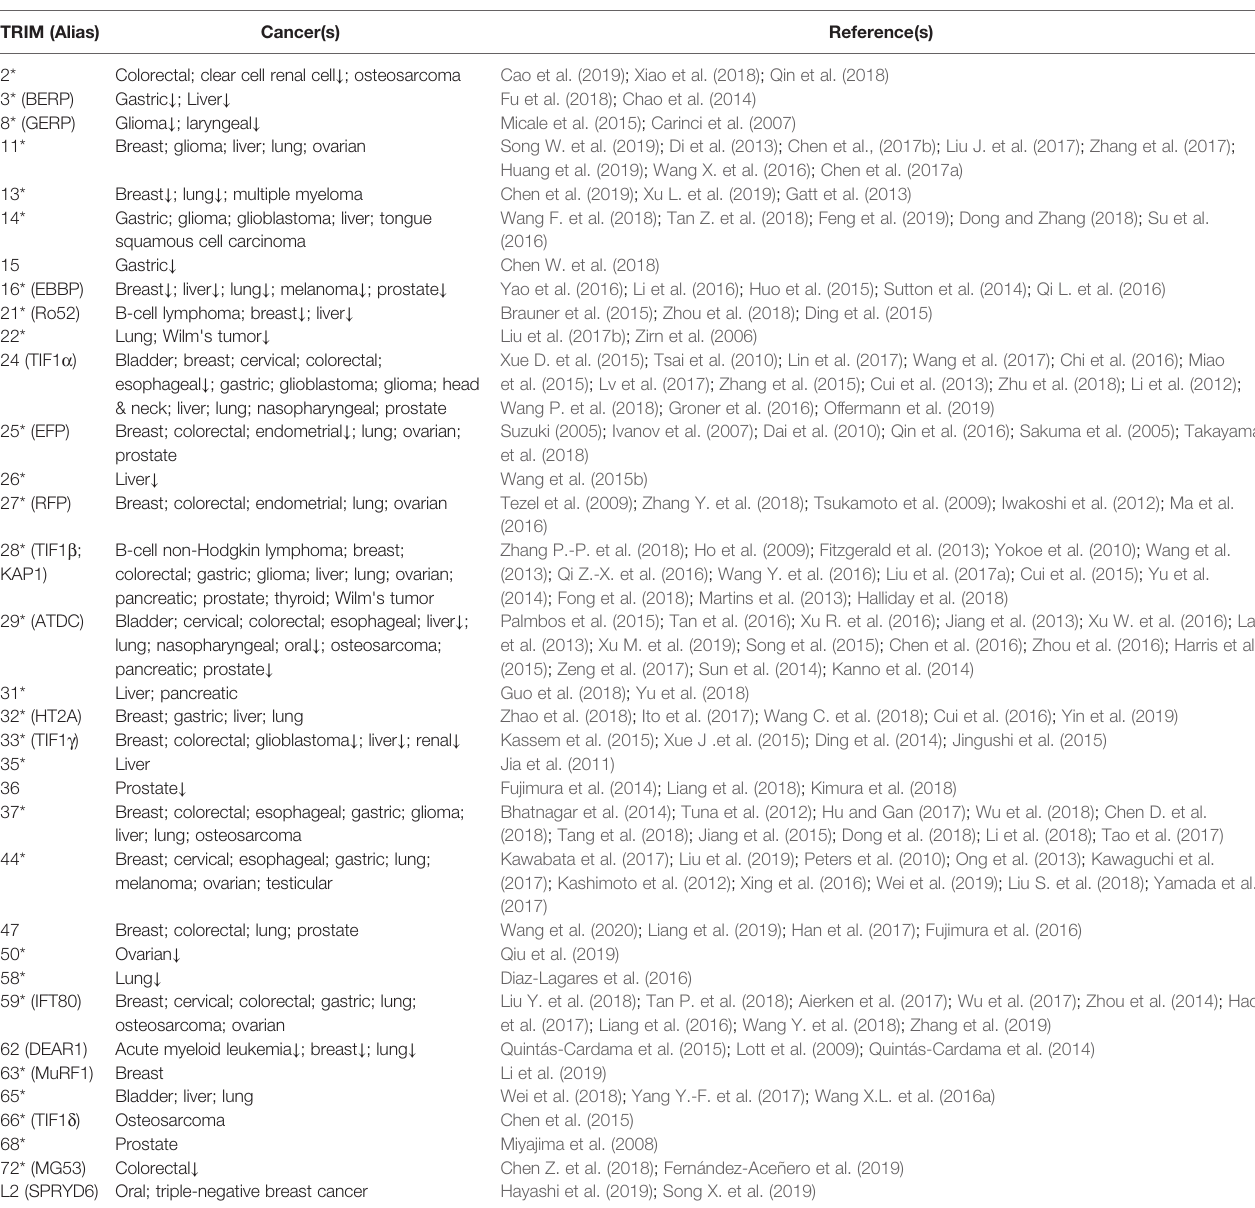
TABLE 1 | TRIM expression changes found in